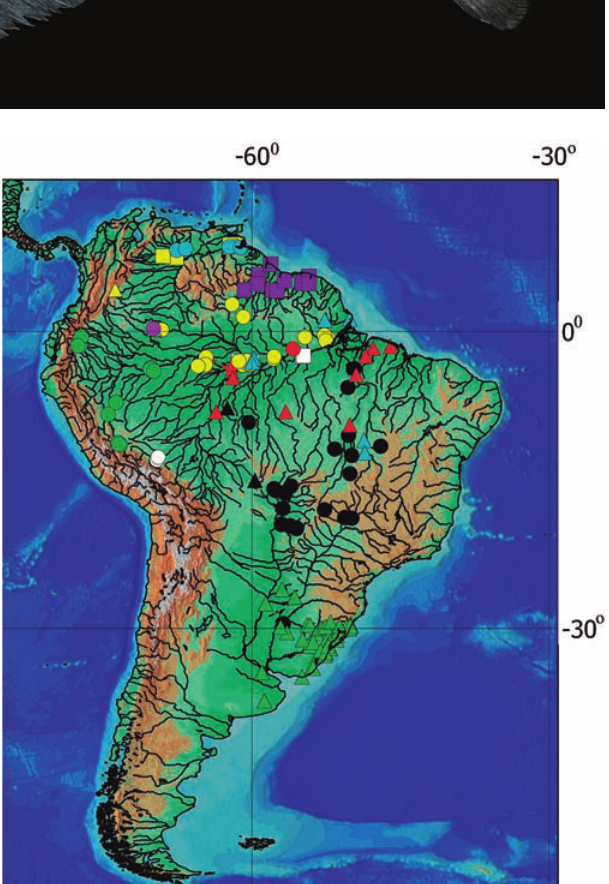
Fig. 7. Map of South America showing the collecting sites of the Charax species, and the type locality of Charax delimai (purple circle). Charax apurensis - yellow square; C . caudimaculatus - white circle; C . condei - white square; C . gibbosus - purple triangle; C . hemigrammus - red star; C . leticiae - black circle; C . macrolepis - black triangle; C. metae - yellow triangle; C. michaeli - yellow circle; C. niger - blue triangle; C. notulatus - blue circle; C. pauciradiatus - red triangle; C. rupununi - red circle; C. stenopterus - green triangle; C. tectifer - green circle. Some symbols may represent more than one